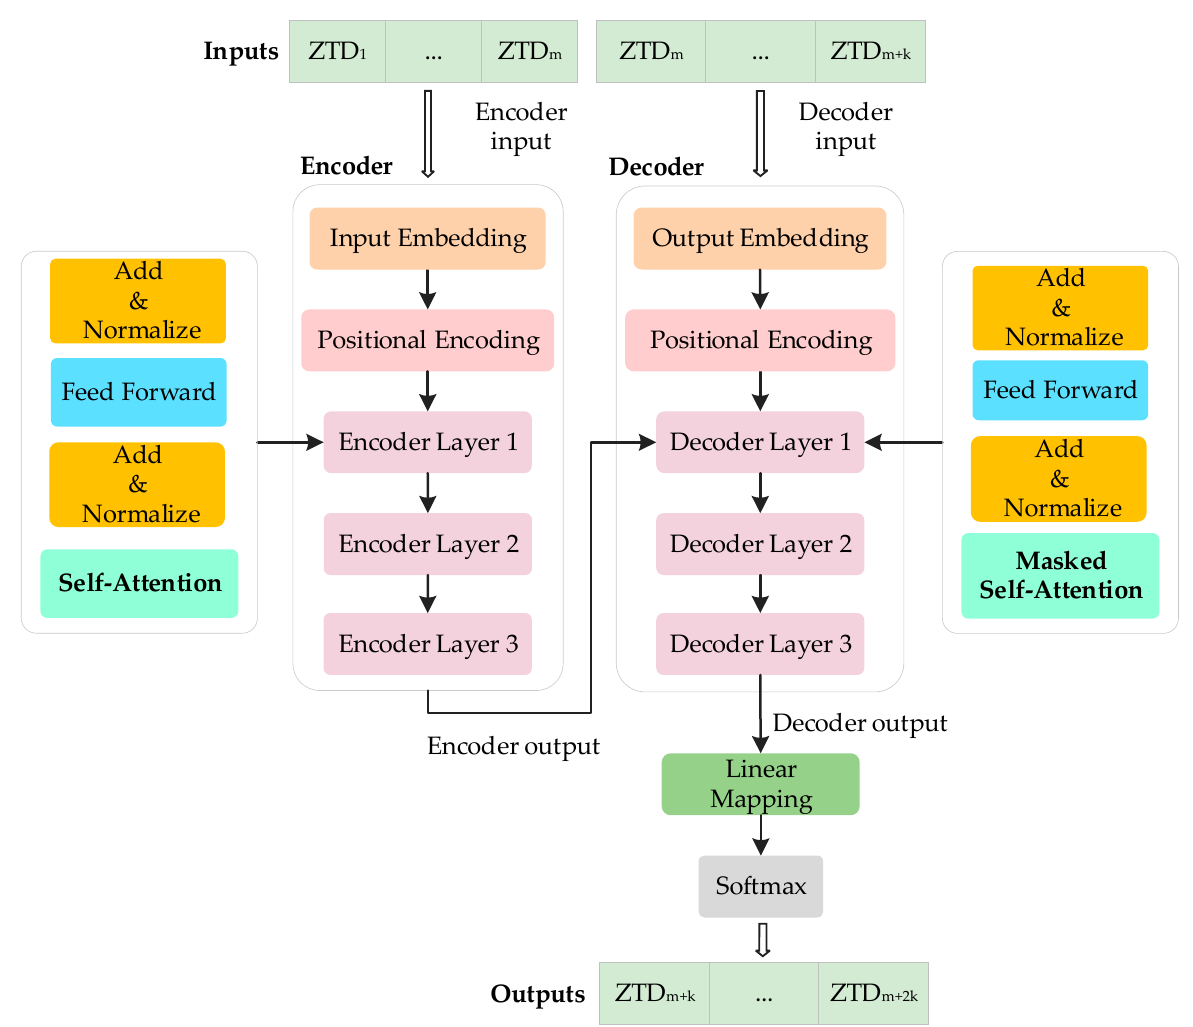
Figure 2. Transformer ZTD forecasting model structure designed in this study. The m and k denote the length of the whole ZTD sequence and the subsequence, respectively.